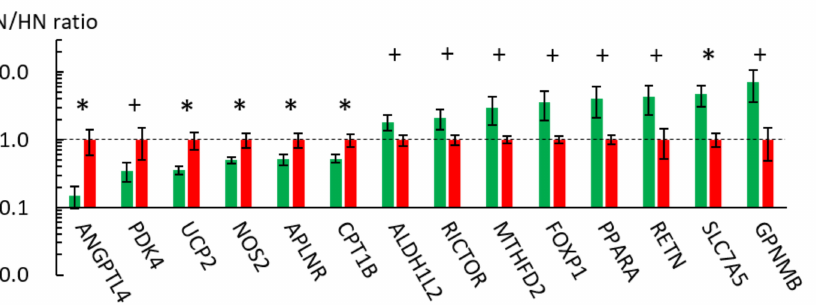
Figure 2. qPCR results of highly down- and upregulated fetal skeletal muscle genes in microarray analysis. The ratios of the normalized gene expression of the LN (green) to HN (red) fetuses are shown as columns. RPL7 was used as the internal control. Error bars indicate SEM. * and + indicate differences between the LN and HN fetuses at p < 0.05 and p < 0.10, respectively. PDK4 : pyruvate dehydrogenase kinase 4, NOS2 : nitric oxide synthase 2, CPT1B : carnitine palmitoyltransferase 1B, MTHFD2 : methylenetetrahydrofolate dehydrogenase (NADP+ dependent) 2, methenyltetrahydrofo- late cyclohydrolase, RICTOR : RPTOR independent companion of MTOR complex 2, FOXP1 : forkhead box P1, PPARA : peroxisome proliferator activated receptor alpha, RETN : resistin, SLC7A5 : solute carrier family 7 member 5, GPNMB : glycoprotein nmb, ALDH1L2 : aldehyde dehydrogenase 1 family member